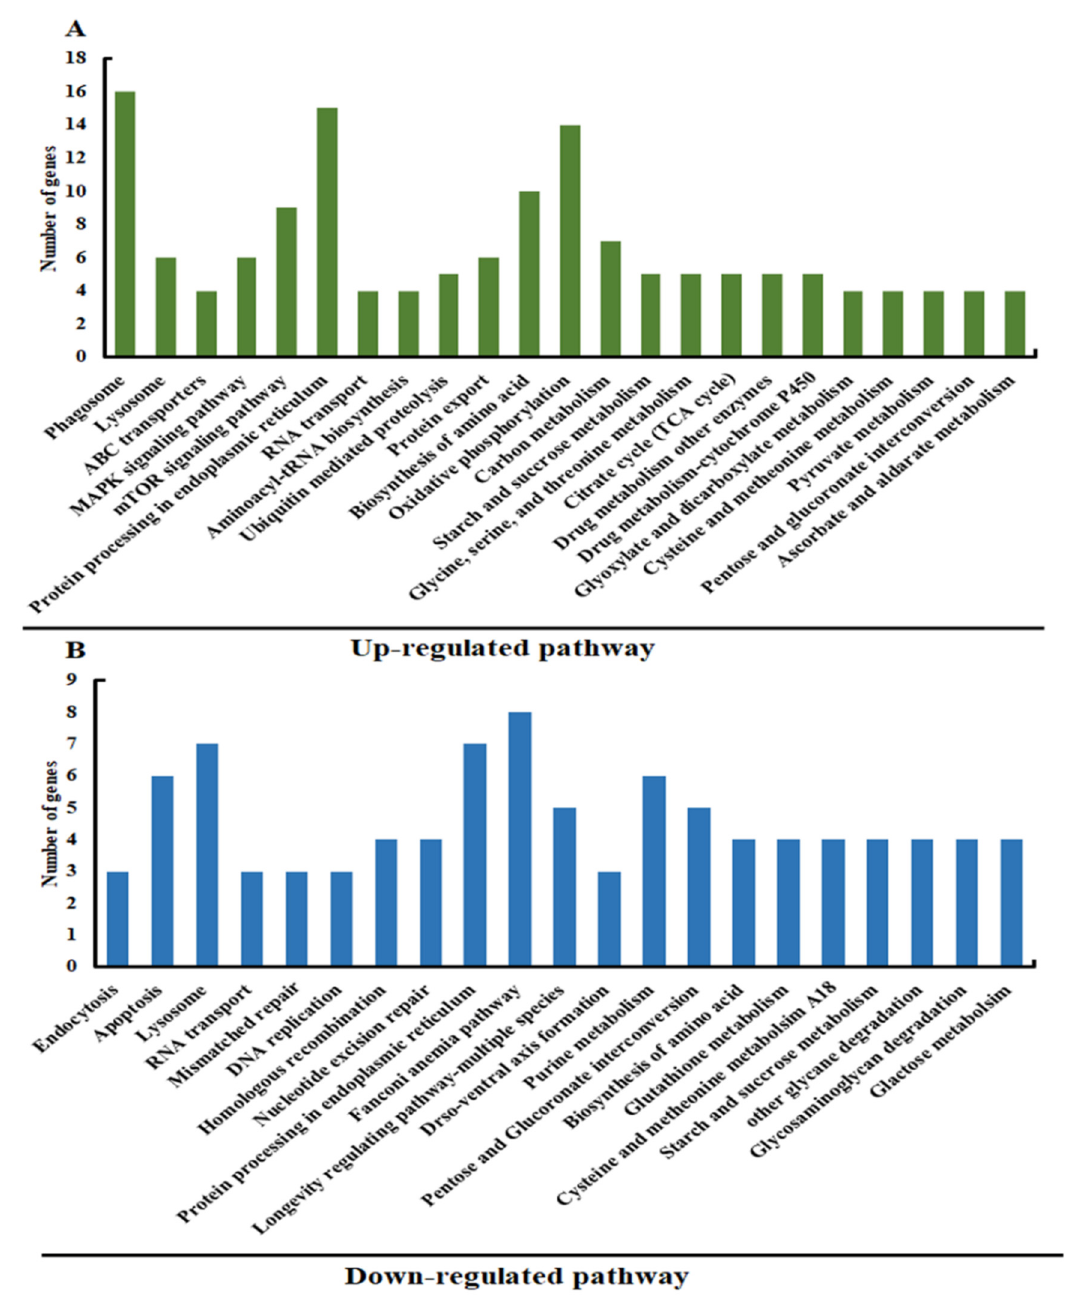
Figure 4. ( A ): The top 21 enriched pathways for the up-regulated genes. ( B ): The top 21 enriched pathways for the down-regulated genes.